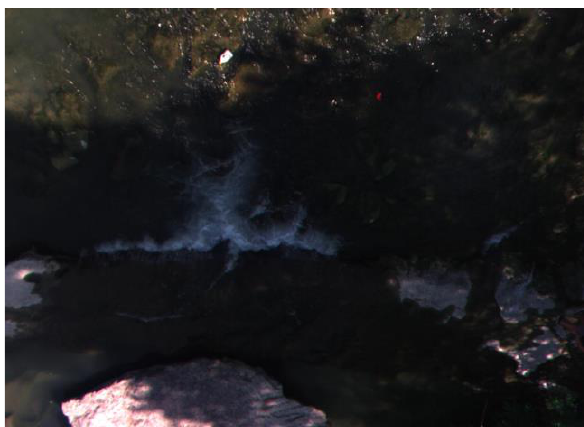
Figure 7. Image of the dataset represented in RGB. It is possible distinguish two plastic sample (white bottle in top-center and red, in the top-right).